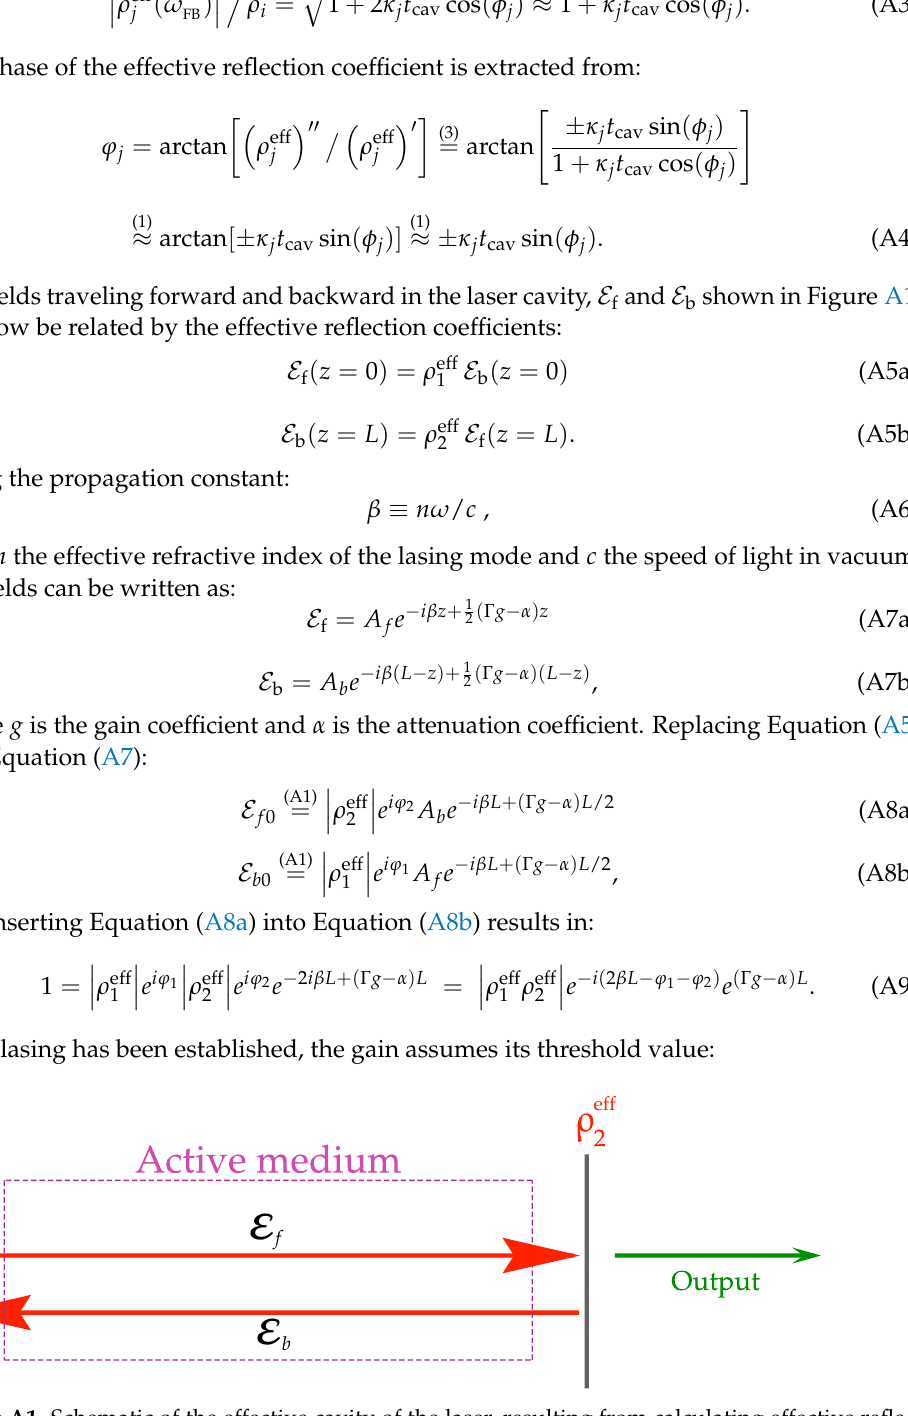
Figure A1. Schematic of the effective cavity of the laser, resulting from calculating effective reflec- tion